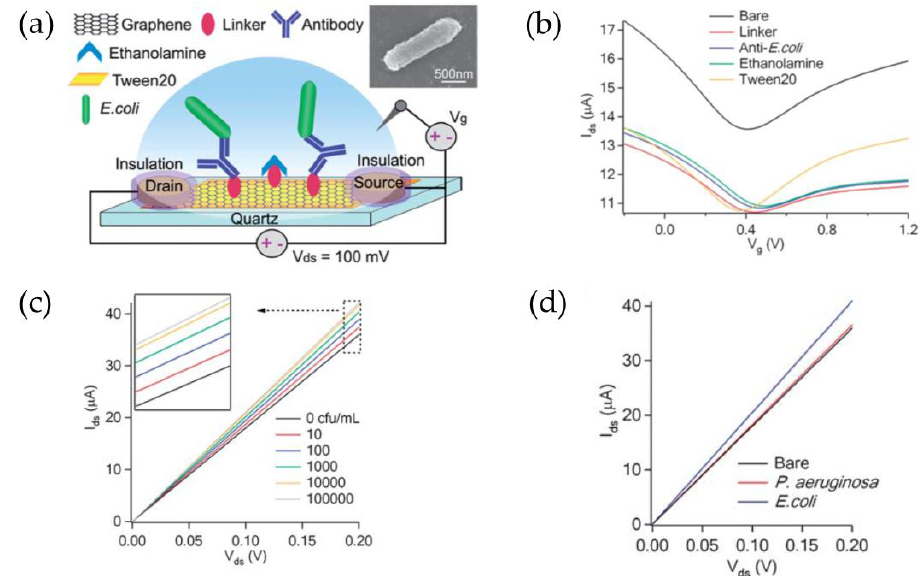
Figure 4. ( a ) Scheme showing a graphene-based FET sensor operating in an electrolyte solution for detecting E. coli bacteria. Bacterial cells were attached to antibodies immobilized onto the graphene surface; ( b ) Transfer curves (I DS × V G ) of the graphene-FET sensor. Graphene exhibited ambipolar characteristics; ( c ) I DS × V DS curves of graphene FET devices on various E. coli concentrations; ( d ) I DS × V DS characteristics of devices after incubation with P. aeruginosa , demonstrating high